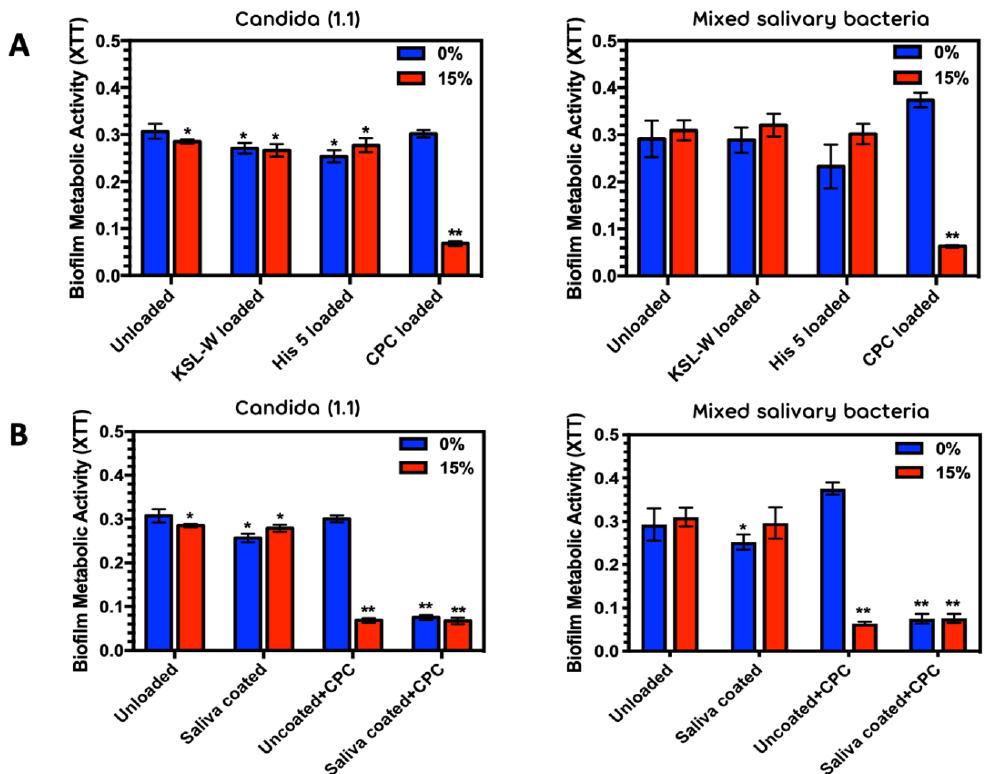
Figure 2. ( A ) Effects of Histatin 5, KSL-W, and CPC on Candida (1.1) biofilm metabolism and mixed salivary bacteria biofilm metabolism on 0 and 15% phosphated PMMA and ( B ) Antimicrobial effect of CPC on Candida (1.1) biofilm metabolism and mixed salivary bacterial biofilm metabolism in the presence or absence of a salivary pellicle on 0 and 15% phosphated PMMA. Average values and standard deviations were taken from six replicate disks for each condition. *;** Statistically significant reduction in metabolic activity compared to PMMA control (0%